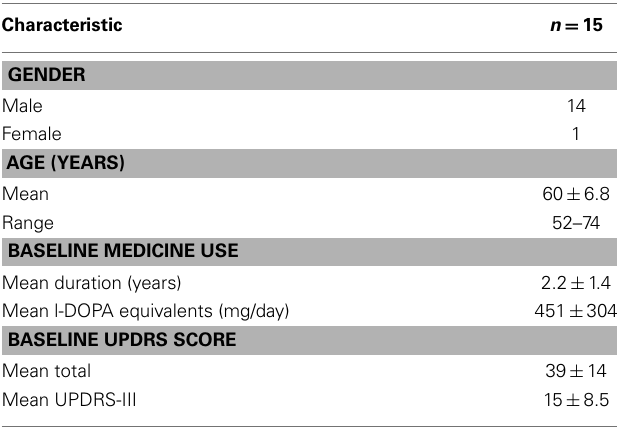
Table 1 | Baseline characteristics of patients [adapted with permission from Charles et al. (7), l-DOPA equivalency based on equation from Deusch et al.